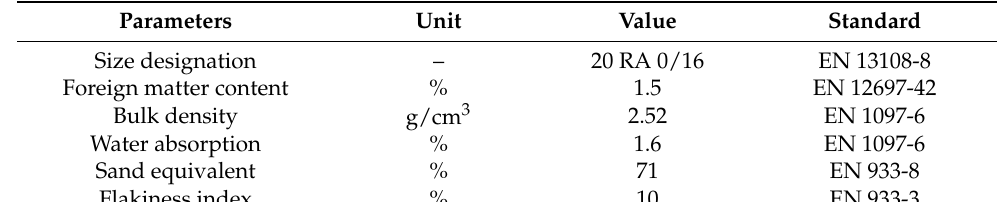
Table 2. Main features of RAP.